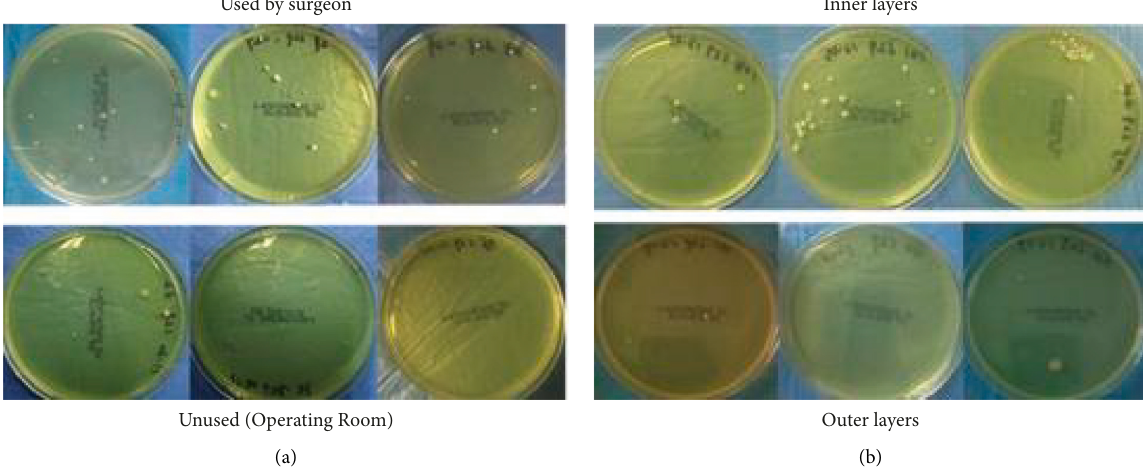
Figure 2: Comparison of bacterial contamination of masks: (a) used by the surgeon versus unused masks in the operating room and (b) inner layers versus outer layers (adapted with permission from Reference. [12]).